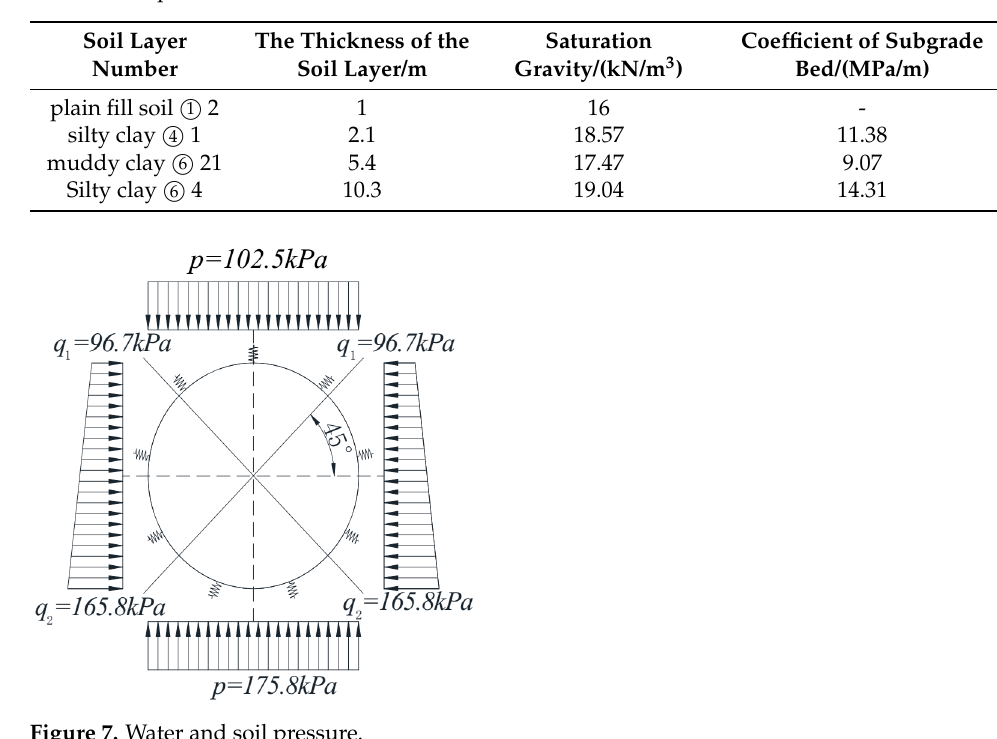
Figure 7. Water and soil